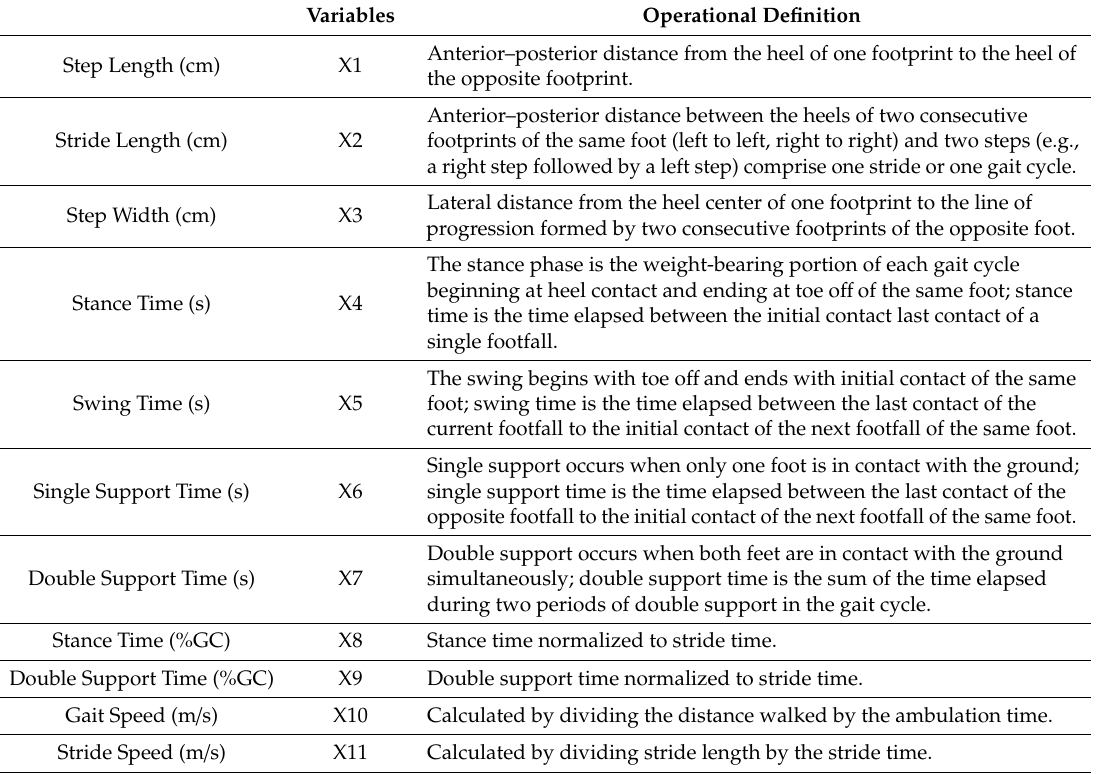
Table 4. Operational definitions of gait parameters and